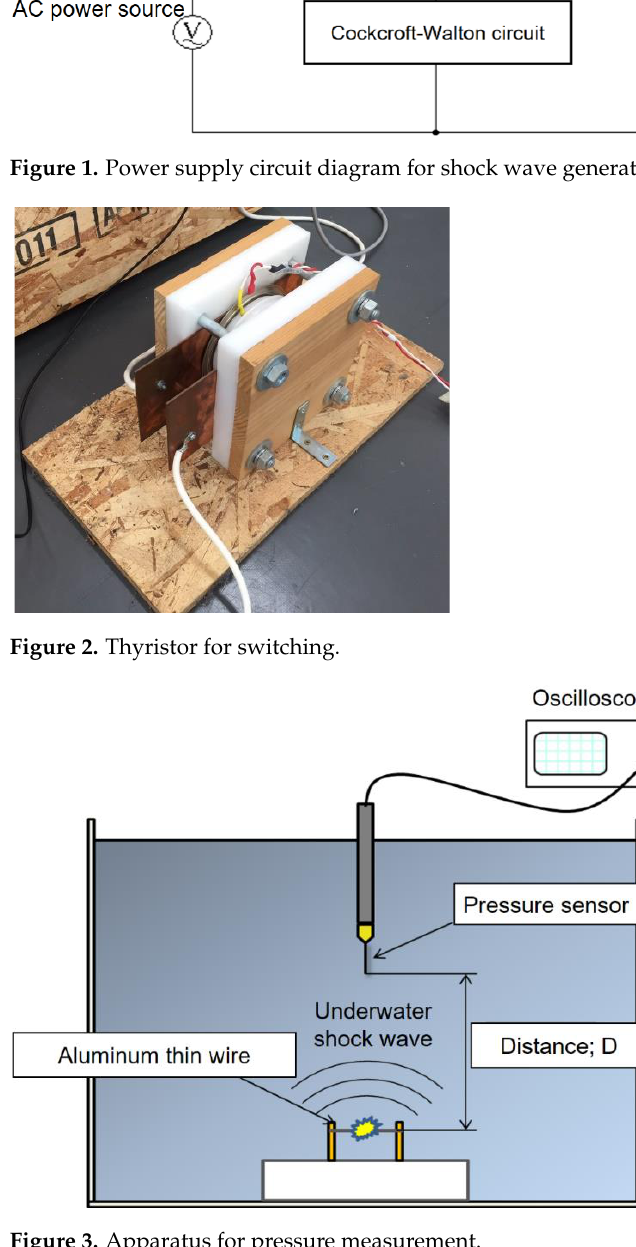
Figure 3. Apparatus for pressure measurement.